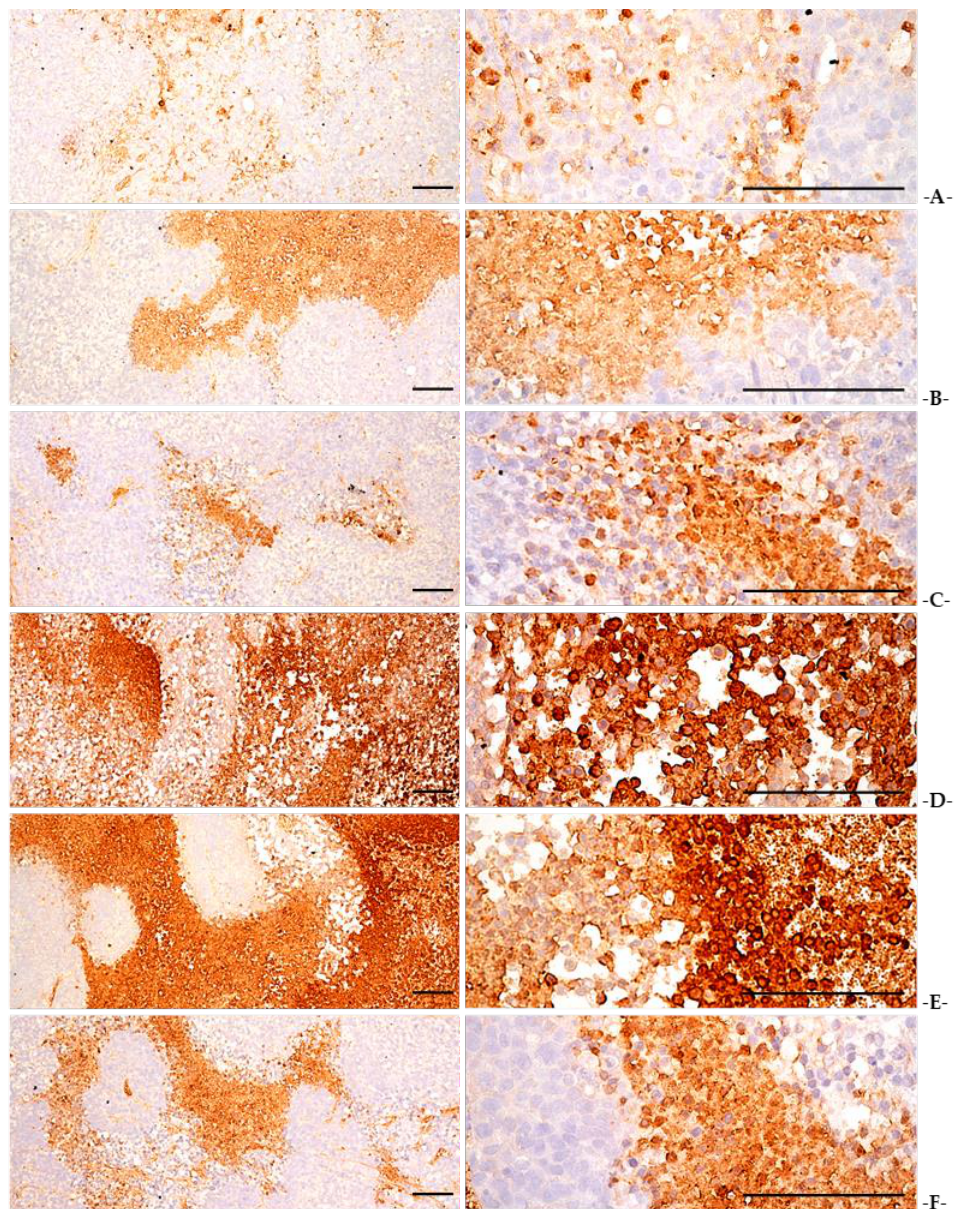
Figure 9. Representative PARP immunoreactivities of the tumor masses taken from NCI-H520 tumor cell xenograft mice. ( A ) = Tumor-bearing control; ( B ) = 120 mg/kg-gefitinib-single-treated rodents; ( C ) = 400 mg/kg-SKOG-single-treated rodents; ( D ) = gefitinib 120 mg/kg and SKOG 400 mg/kg; ( E ) = gefitinib 120 mg/kg and SKOG 200 mg/kg; ( F ) = gefitinib 120 mg/kg and SKOG 100 mg/kg. AR = Adenophorae Radix; KOG = Kyeongokgo ; SKOG = sasam-Kyeongokgo . PARP = cleaved poly(ADP-ribose) polymerase. All avidin-biotin complex (ABC) methods. Scale bars = 100 μm.